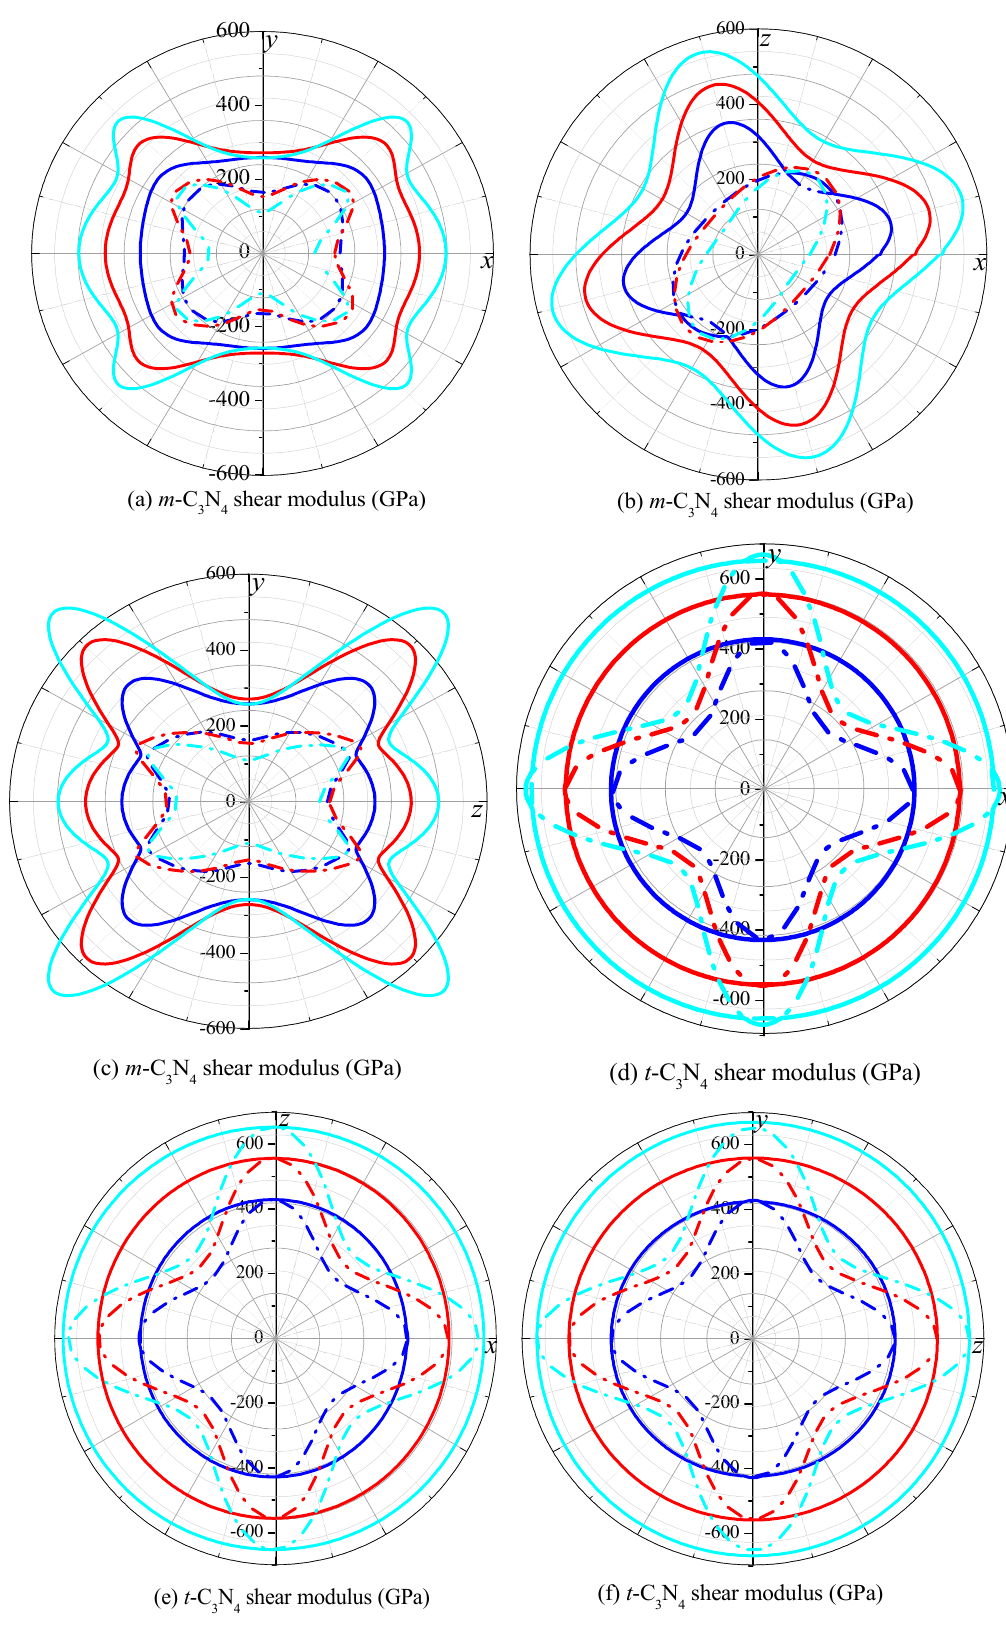
Figure 7. 2D representation of shear modulus in the xy plane, xz plane and yz plane for: m -C 3 N 4 ( a – c ); and t -C 3 N 4 ( d – f ).